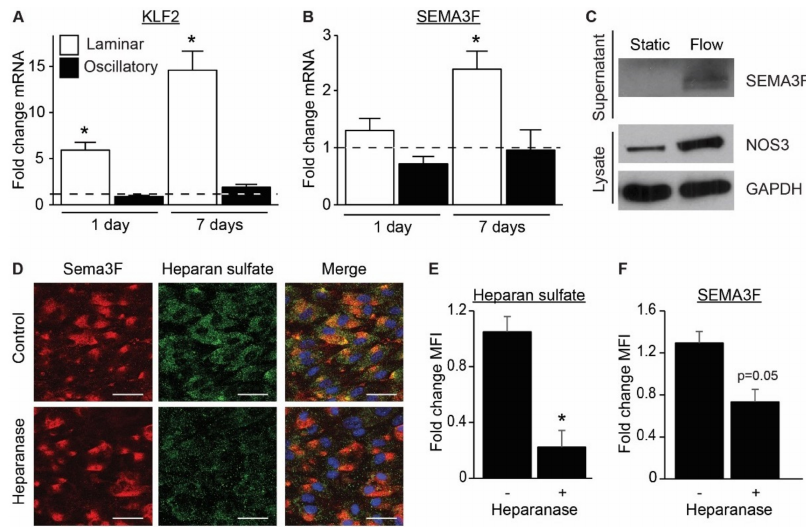
Figure 3. Regulation of SEMA3F expression and secretion by shear stress. ( A , B ) Quantitative qPCR analysis of KLF2 ( A ) and SEMA3F ( B ) mRNA isolated from HUVECs cultured under laminar or oscillatory flow conditions (10 dyn / cm 2 ) for 1 or 7 days compared to static culture conditions. Results are presented relative to static cultured cells, set as 1, dotted line. Mean ± SEM of n = 3, * p < 0.05. ( C ) Immunoblot analysis of SEMA3F protein dimer in the supernatant and NOS3 or GAPDH in cell lysates. Representative of n = 2–3. ( D – F ) Immunofluorescence staining of SEMA3F (red), Heparan sulfate (green) and nuclei (blue) in HUVECs cultured under laminar flow conditions for 7 days and treated with or without heparanase (1.5 µ g / mL) for 2 hours at the end of the 7 days culture. Scale bar 40 µ m. Quantification of mean fluorescence intensity of heparan sulfate ( E ) and SEMA3F ( F ) of 3 independent experiments. Mean ± SEM, * p < 0.05.